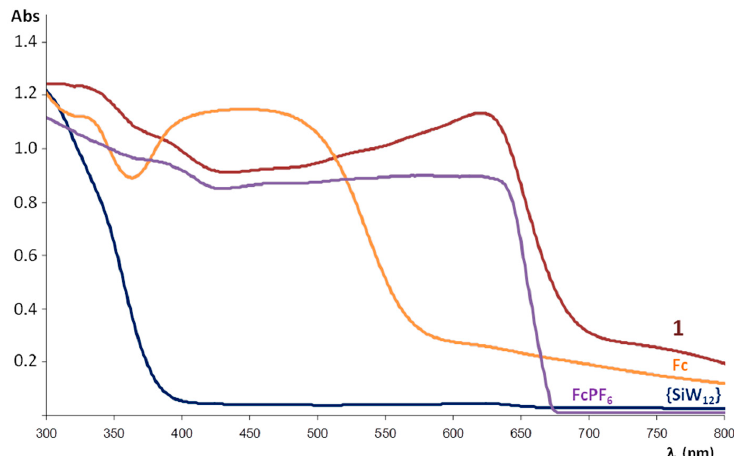
Figure 7. Diffuse Reflectance UV-Vis spectrum of powdered crystalline sample of 1 compared with those of the K 4 [SiW 12 O 40 ]·17H 2 O precursor, ferrocene (Fc) and the FcPF 6 salt.